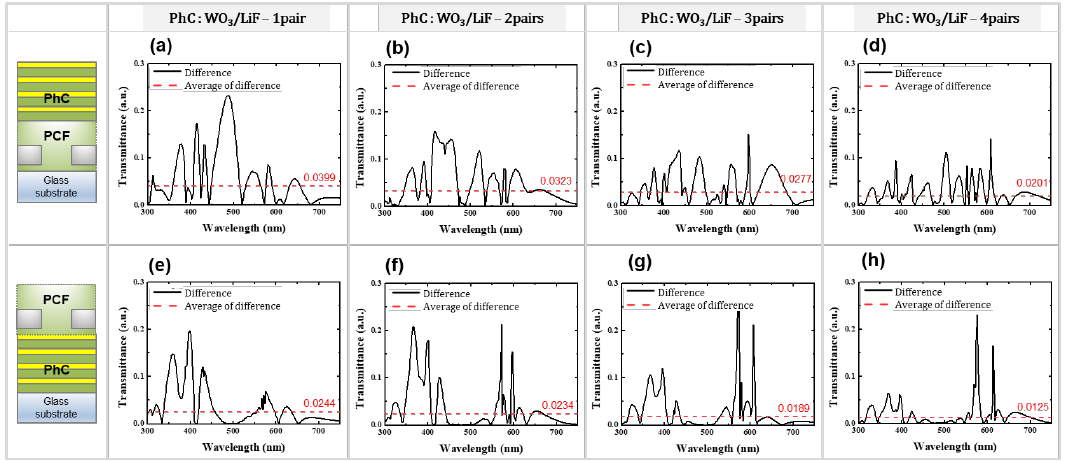
Figure 5. Difference between the calculated and simulated spectra of the PhC-PCF in Figure 4. ( a – d ) show the results for glass/PCF/PhC structures, and ( e – h ) show the results for glass/PhC/PCF structures. The dashed line represents the average values of the differences in each case.